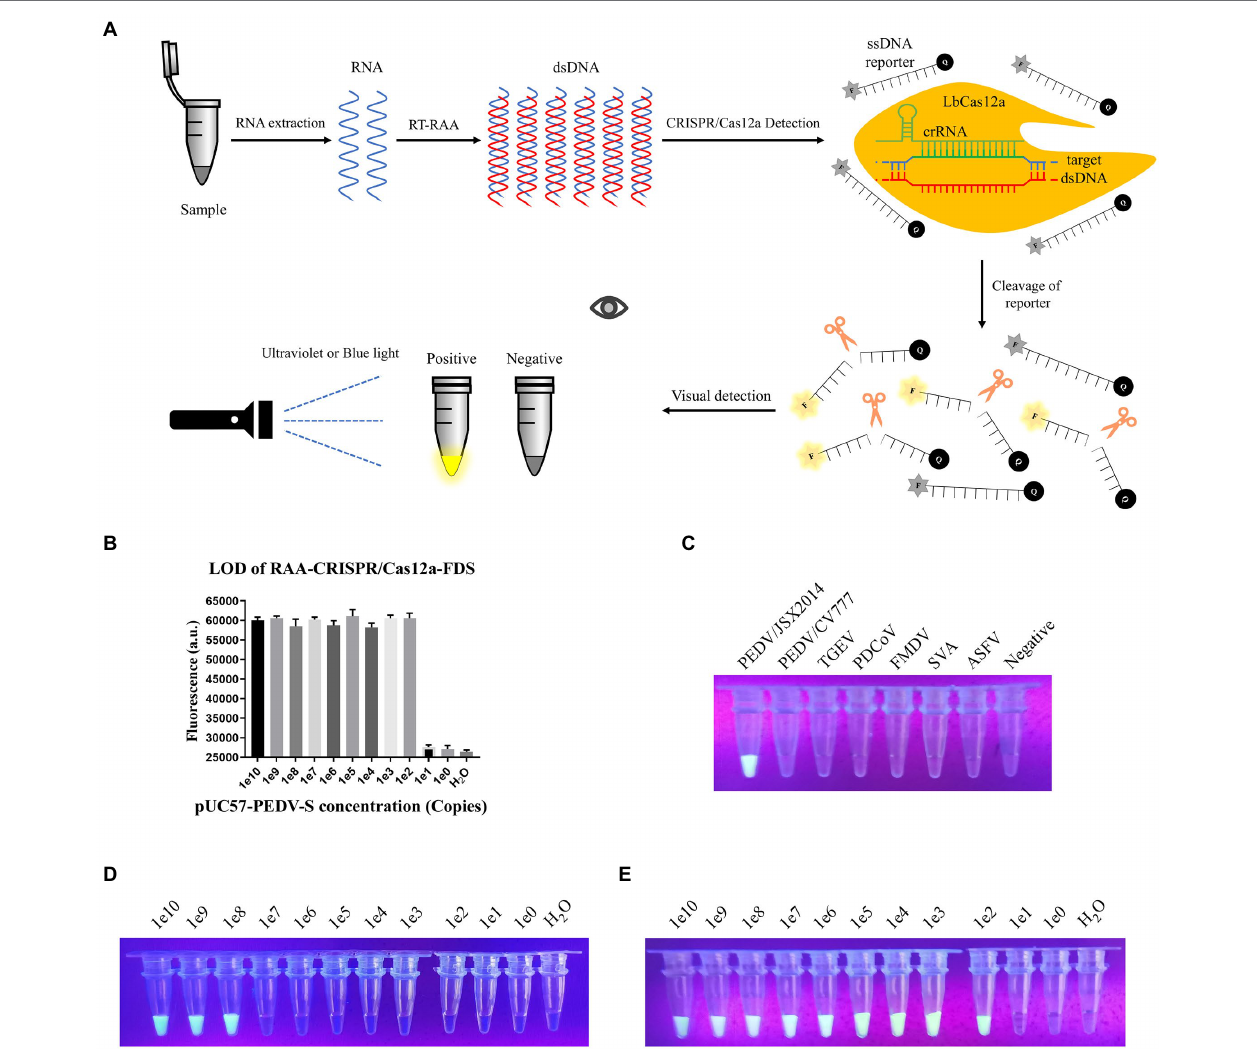
FIGURE 4 | Establishing the Recombinase Aided Amplification (RAA)-CRISPR-FDS. (A) Schematic diagram of PEDV visual detection, the method combines RAA assay, and the CRISPR/Cas12a-FDS. (B) Sensitivity of the CRISPR/Cas12a-FDS combined with RAA. The serially diluted pUC57-PEDV-S plasmid was used as a template. (C) After samples were detected by CRISPR/Cas12a-FDS at 37 ° C, the fluorescence of different porcine viruses was observed under UV light by the gel imaging system at the 30th min. Fluorescence could only be observed in PEDV/JSX2014 tubes. (D) Sensitivity of the CRISPR/Cas12a-FDS visual observations. The serially diluted pUC57-PEDV-S plasmid was used as a template. (E) Sensitivity of the CRISPR/Cas12a-FDS combined with RAA visual observations. The serially diluted pUC57-PEDV-S plasmid was used as a